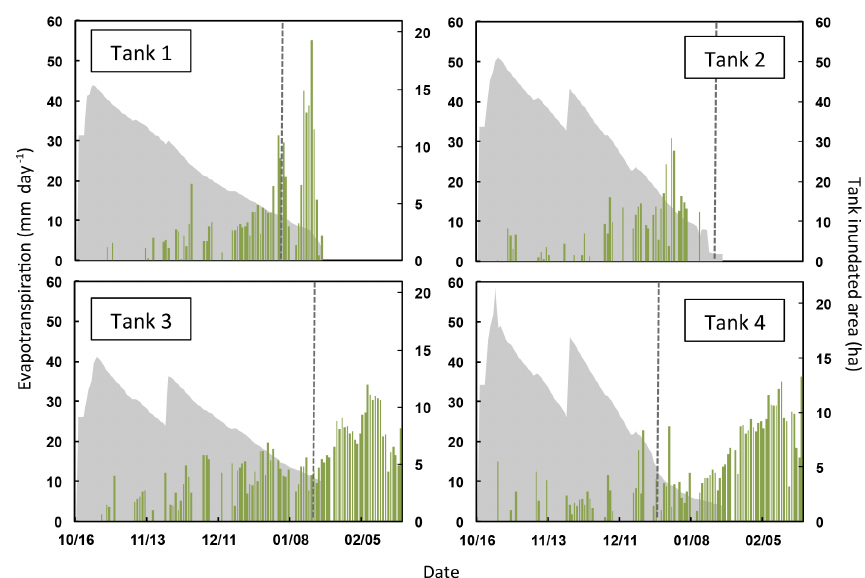
Figure 6. The temporal variation in daily ET over the monsoon season, shown as green bars. There are data gaps in the figure since estimates were made using the White method only on nonrainfall days. ET increases towards the later part of the season, coincident with decreases in tank surface area (shown as the grey shaded area). ET rates are reasonable for the region and season when the inundated area is greater than 25% of maximum area, as indicated by the dashed line.